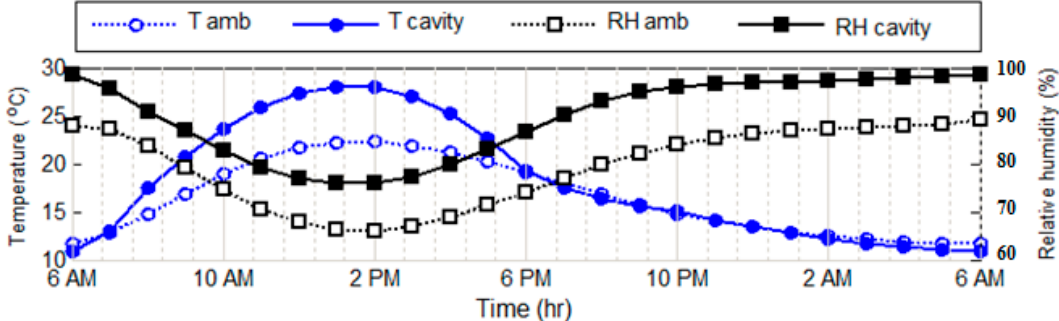
Figure 22. Climate conditions—Egyptian GH—for a typical day of 21st March, Borg El-Arab, Egypt.